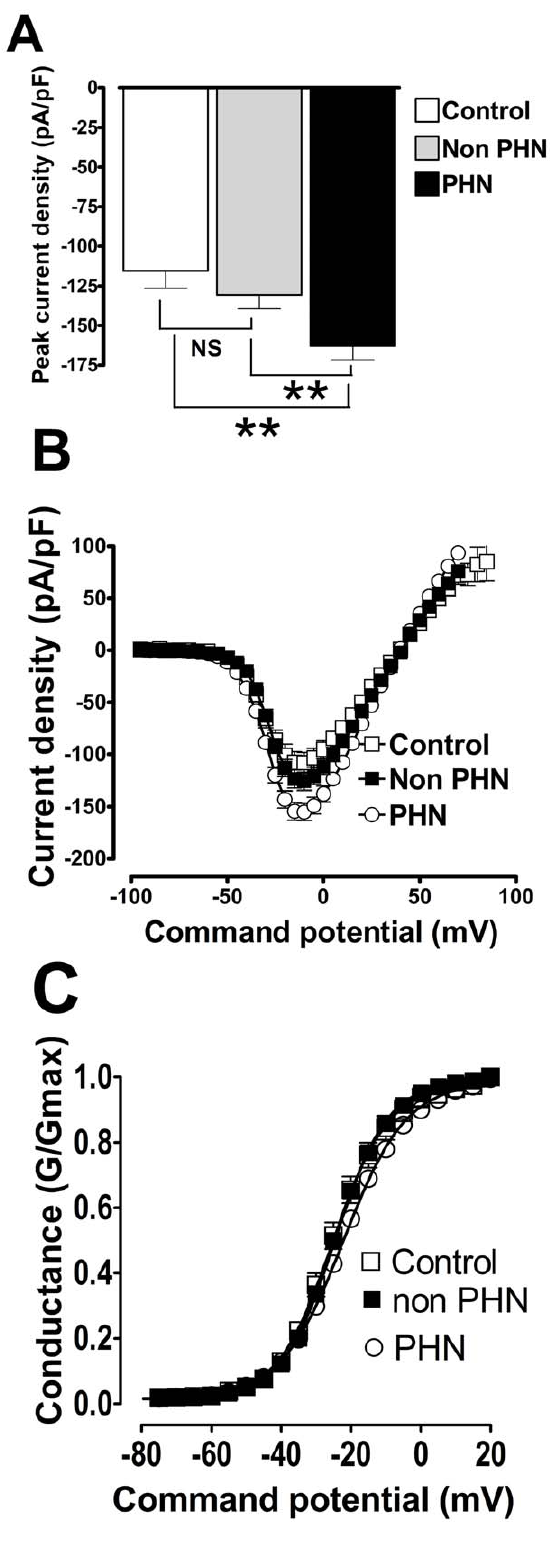
Figure 3. VZV isolates implicated in post herpetic neuralgia significantly increase sodium current density in ND7-23 1.8 cells. (A) Comparison of peak current densities in sham treated control cells (solid black bar), cells exposed to VZV isolates not implicated in post herpetic neuralgia (non PHN; solid grey bar) and cells exposed to VZV isolates implicated in post herpetic neuralgia (PHN, open